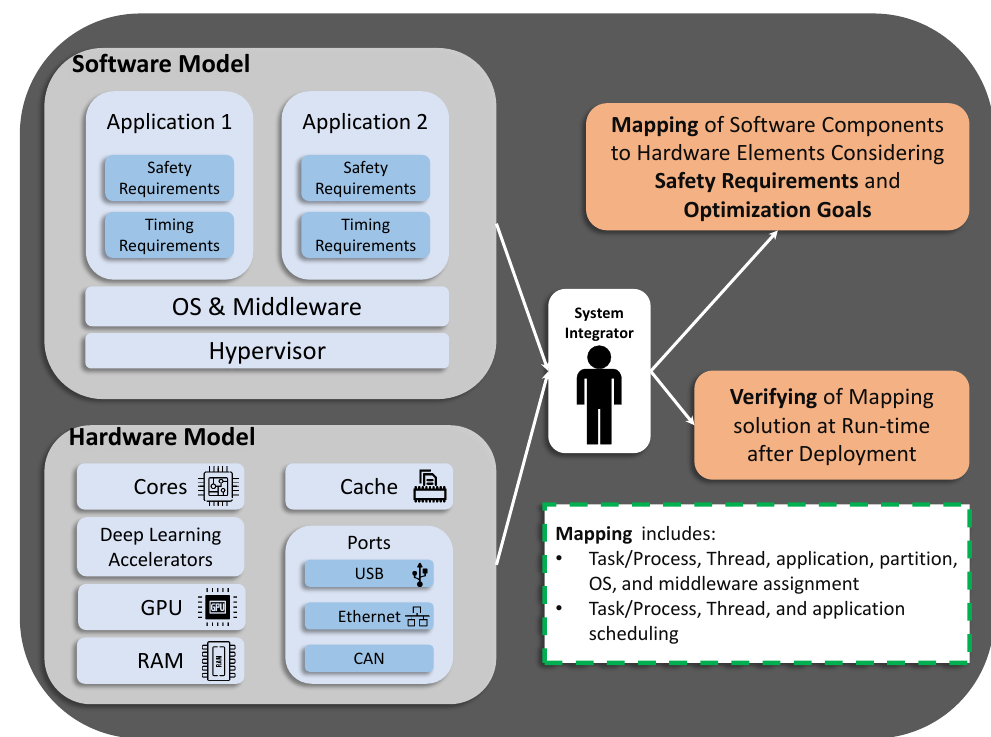
Figure 3. The manual procedures have to be executed by a system integrator to map automotive software components to an automotive